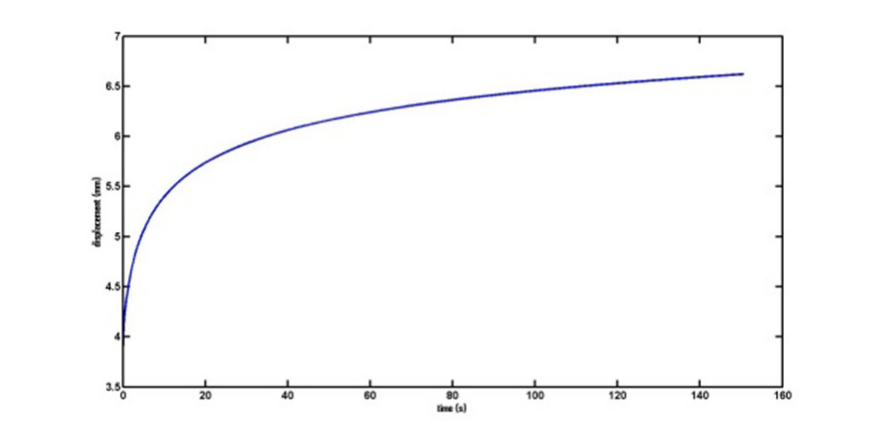
Fig. 4 Creep at 6000N load